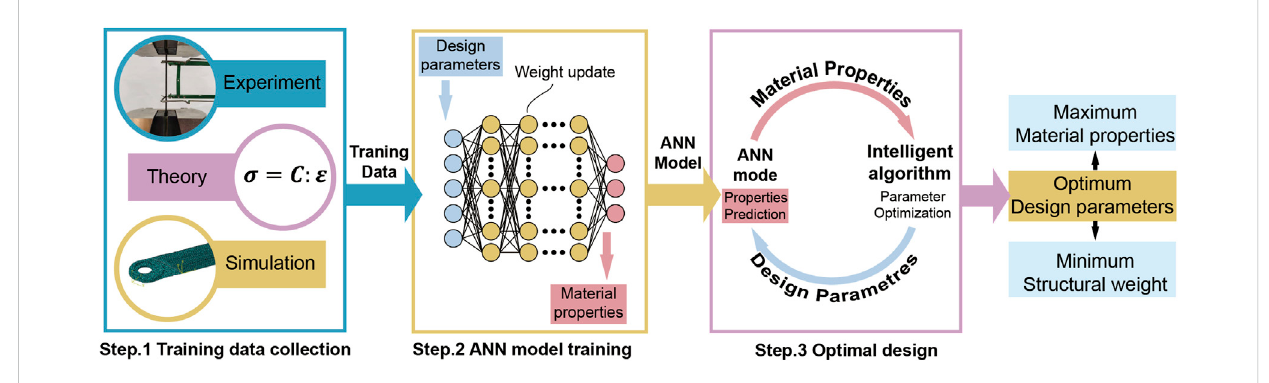
FIGURE 8 Combination of ANN and intelligent algorithm for optimal design.